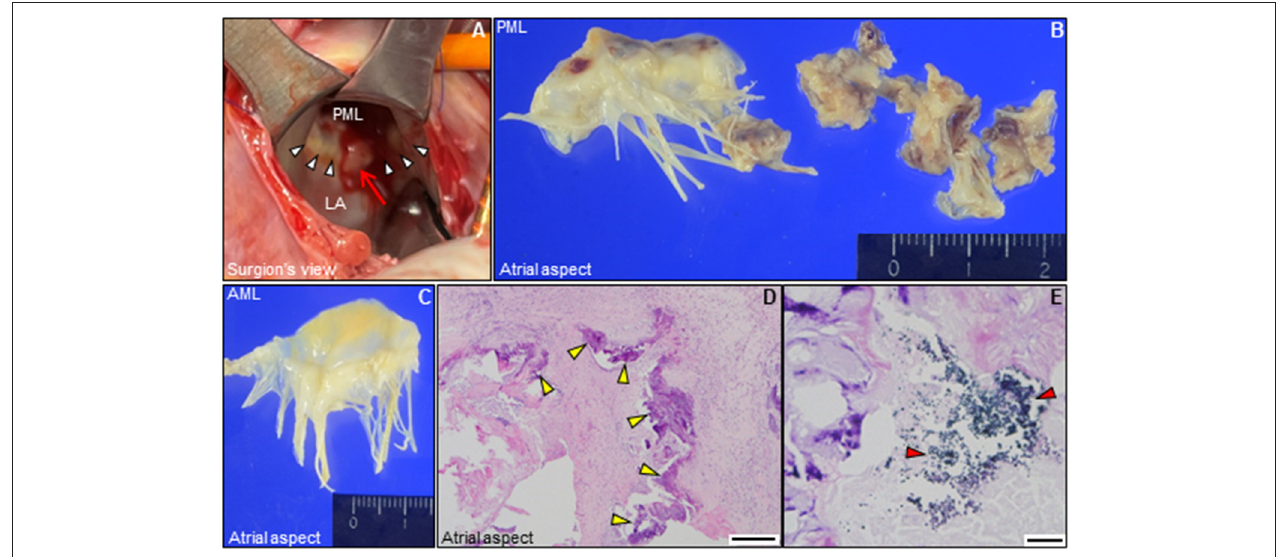
FIGURE 3 | Intraoperative and pathological findings. (A) Intraoperative view of the mitral valve. A large mass of vegetations superimposed on mitral annular calcification (arrow) is observed around the P2 segment in the posterior mitral annulus (white arrowheads). (B,C) Representative macro-photographs of the extracted mitral valve leaflets ( B , PML; C , AML). (D,E) Histological findings of the resected PML shows dystrophic calcification (yellow arrowheads), and surrounding neutrophilic inflammatory cell infiltration and bacterial agglomeration (red arrowheads) [ (D) hematoxylin and eosin staining, Bar 200 µ m; (E) , gram staining, Bar 20 µ m]. AML, anterior mitral leaflet; LA, left atrium; PML, posterior mitral